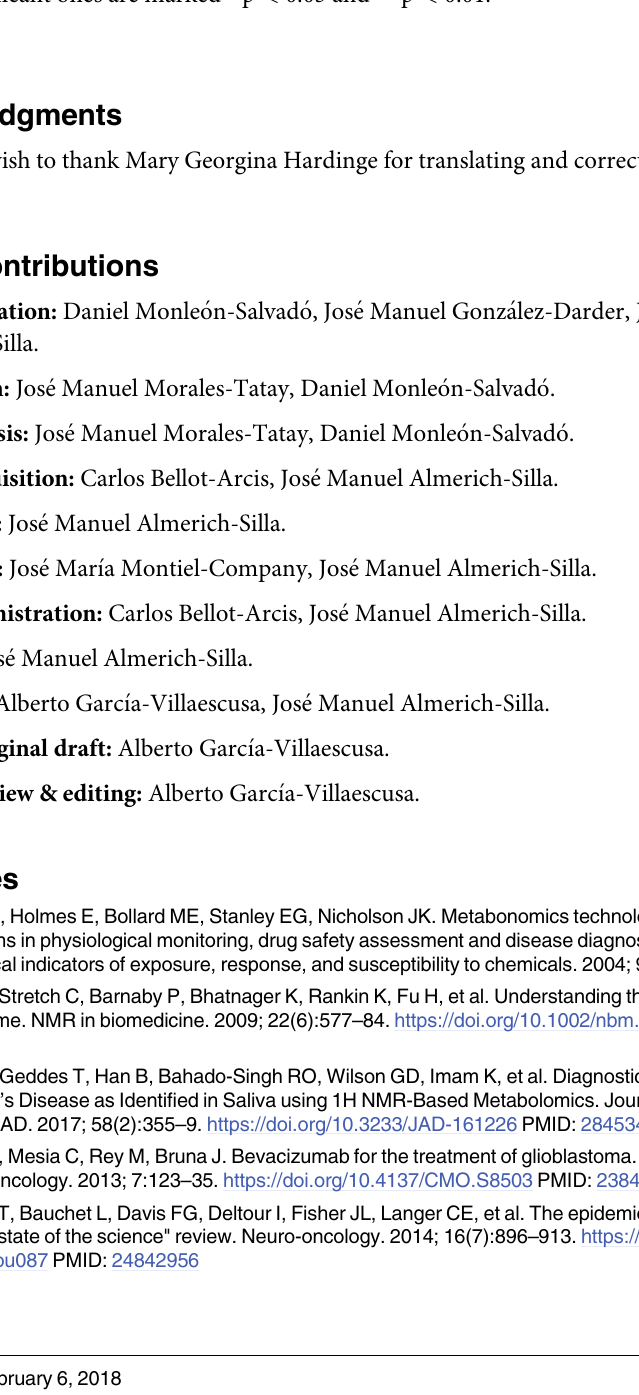
S1 Table. Metabolites identified and compared between GBL and control groups. The sta- tistically significant ones are marked (cid:3) p < 0.05 and (cid:3)(cid:3) p < 0.01. S2 Table. Metabolites identified and compared attending the periodontal satatus. The sta- tistically significant ones are marked (cid:3) p < 0.05 and (cid:3)(cid:3) p <